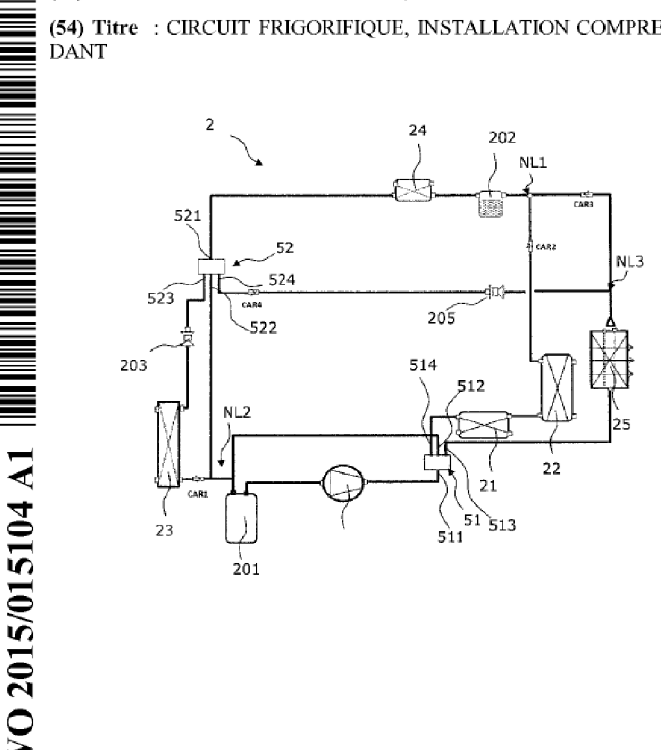
Figure 23. First page of the patent of Ghoubali et al. [67].